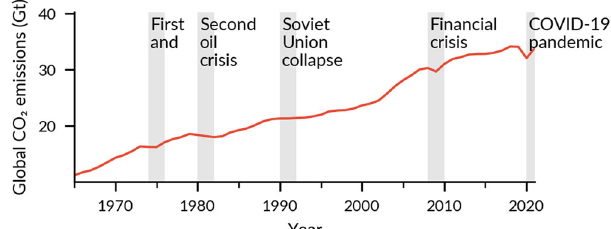
Fig. 1 CO 2 emissions and major economic crises. Global CO 2 emissions from fossil fuel combustion. The grey shades represent the fi ve biggest economic crises in 1965 – 2021. Source: 31 .